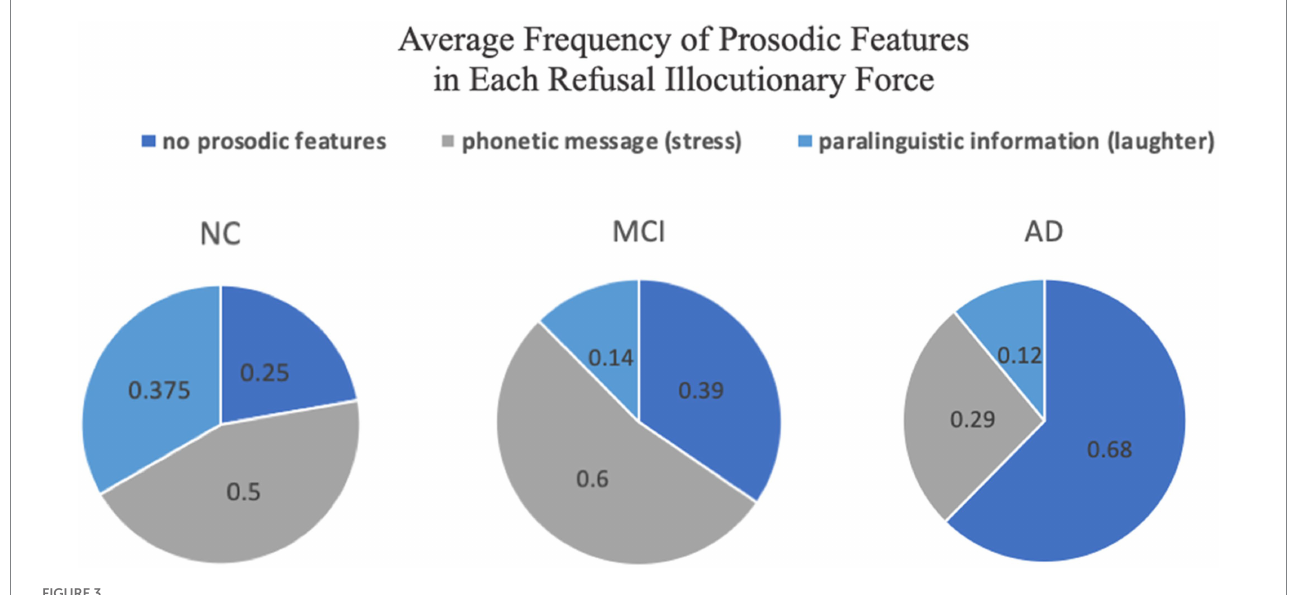
FIGURE 3 Average frequency of different types of prosodic features in each RIF.